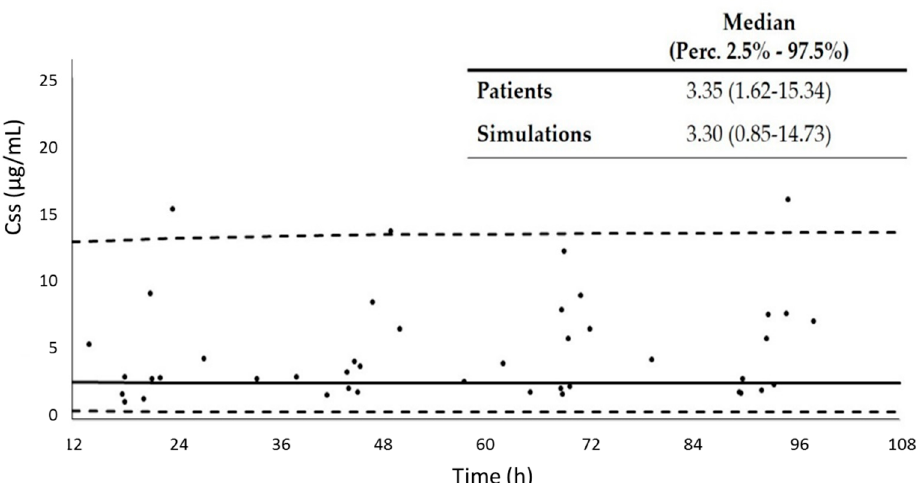
Figure 3. Comparison of the concentrations at steady-state (Css) observed in the patients used for the validation of the model, and the median value and 2.5% and 97.5% percentiles obtained by simulation, using the final model. Dots: experimental concentrations; continuous line: median of the simulated concentrations; dashed lines: 2.5th and 97.5th percentiles of the simulated concentrations.